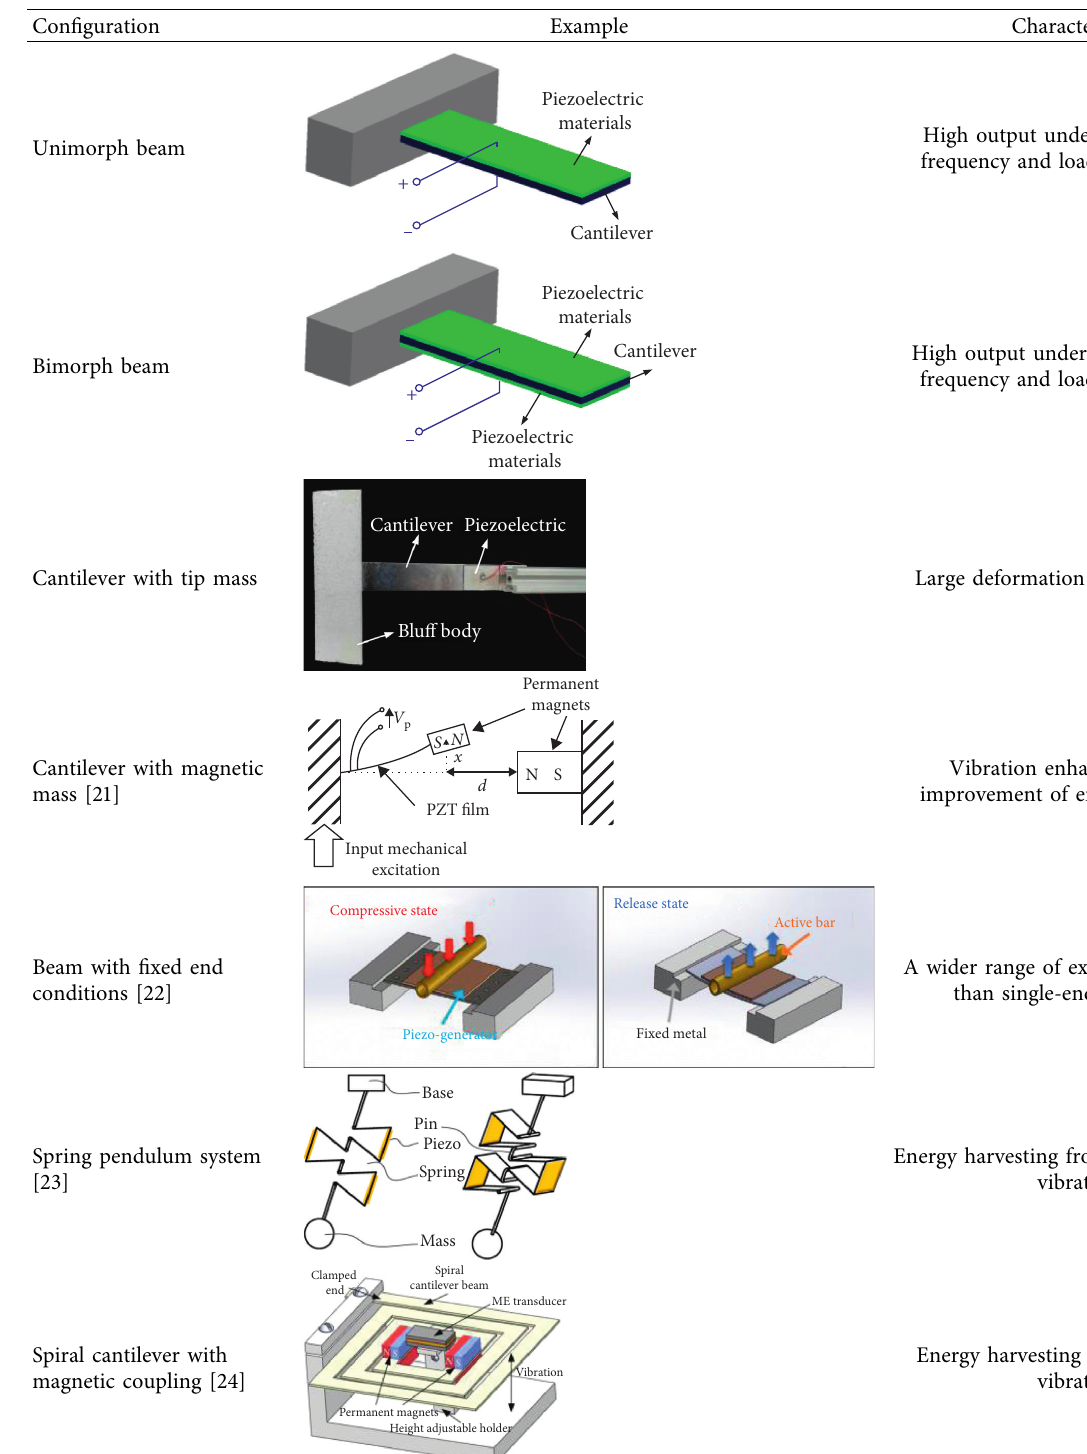
Table 2: Types of architecture configuration for the piezoelectric